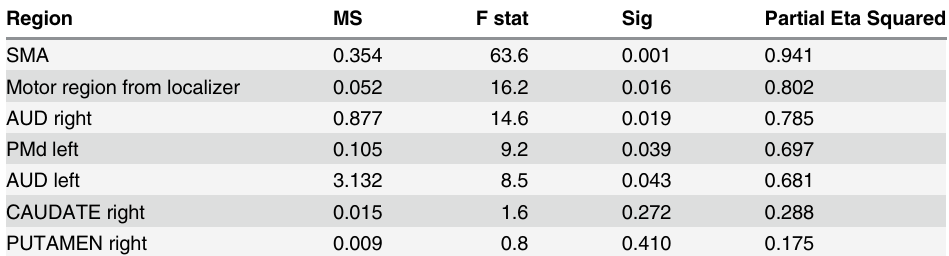
Table 1. Quadratic fits from the time points of 1, 7 and 34 weeks of BOLD signals across regions. Region MS F stat Sig Partial Eta Squared SMA 0.354 63.6 0.001 0.941 Motor region from localizer 0.052 16.2 0.016 0.802 AUD right 0.877 14.6 0.019 0.785 PMd left 0.105 9.2 0.039 0.697 AUD left 3.132 8.5 0.043 0.681 CAUDATE right 0.015 1.6 0.272 0.288 PUTAMEN right 0.009 0.8 0.410 0.175 SMA = Supplementary Motor Area, motor region (localized from the foot motor task), PMd = Dorsal premotor cortex, AUD = auditory